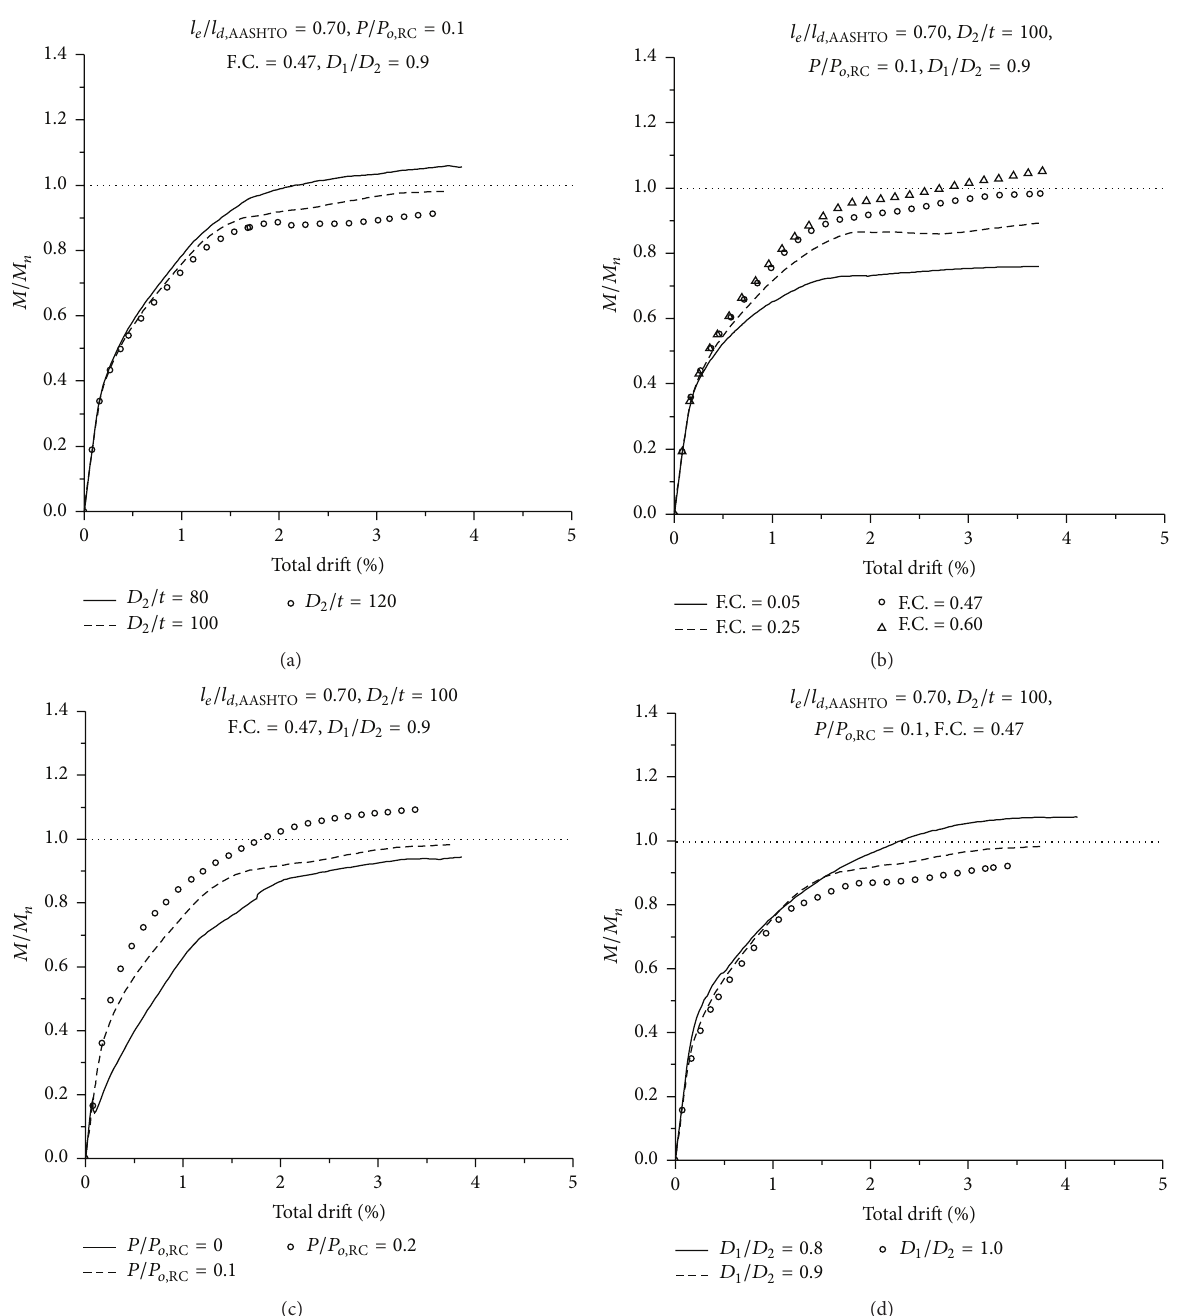
F.C. = 0.47 F.C. = 0.60